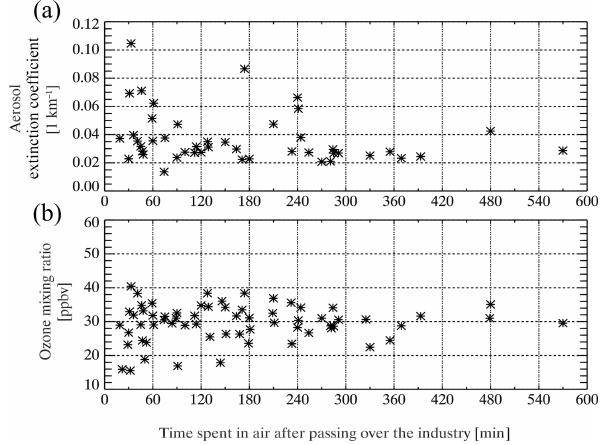
Figure 10. (a) The aerosol optical extinction coefficient and (b) the O 3 mixing ratio as a function of time since the air had passed over the industry to reach the measurement point along all Twin Otter flight tracks. The measurements shown here were collected between 22 and 26 August